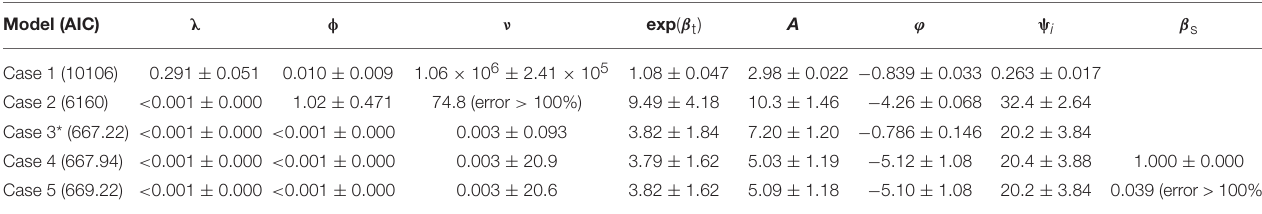
TABLE 2 | Best-fit estimates of the hhh4 homogeneous model parameters (Equations 5, 6) and associated Standard Errors (SE) for endemic, ν , and epidemic [i.e., autoregressive, λ = exp ( α ( λ ) ) , and spatio-temporal, φ = exp ( α ( φ ) ) ] contributions are shown for each of the cases considered: case 1—JRA reanalysis only ( ∼ 55km), case 2—ACIS climate only ( ∼ 10km), and case 3—multiscale with both JRA and ACIS, and two susceptibility corrections of the best-fitting homogeneous model i.e., case 3 (indicated by *) (case 4—offset type, case 5—covariate